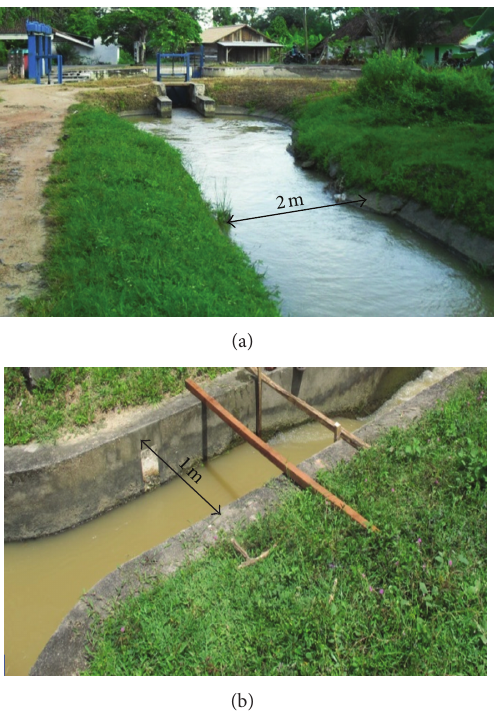
Figure 3: Irrigation canal for turbine